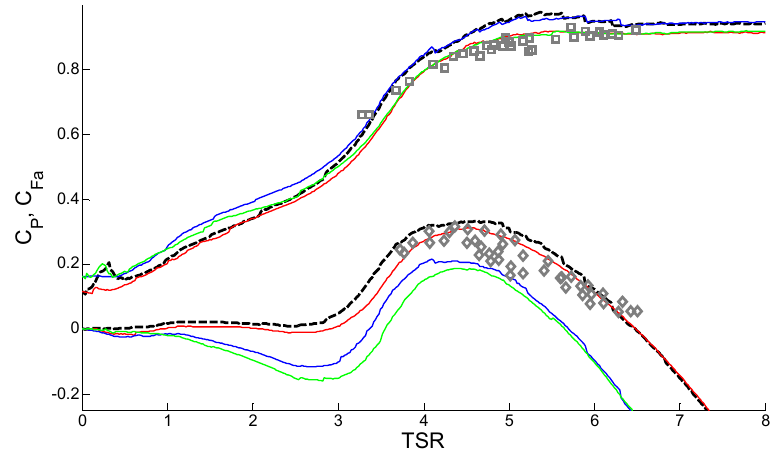
Figure 2. Power (C P ) and axial force (C Fa ) coefficients for (top) Liverpool, (middle) IFREMER and (bottom) Manchester turbines. In all cases, the upper cluster of lines shows C Fa , and the lower shows C P . Black dashed lines show original turbine performance; red lines show the 90% C L case; blue lines show the 150% C D case; green lines show the combined lift decrease and drag increase case. Experimental results are also shown for the IFREMER and Manchester turbines (in grey), with data taken from [9,11], respectively. Note that for the range of TSR values investigated, both the Liverpool and Manchester turbines go beyond the freewheeling state ( i.e. , C P = 0); in a real turbine, this operating condition cannot be